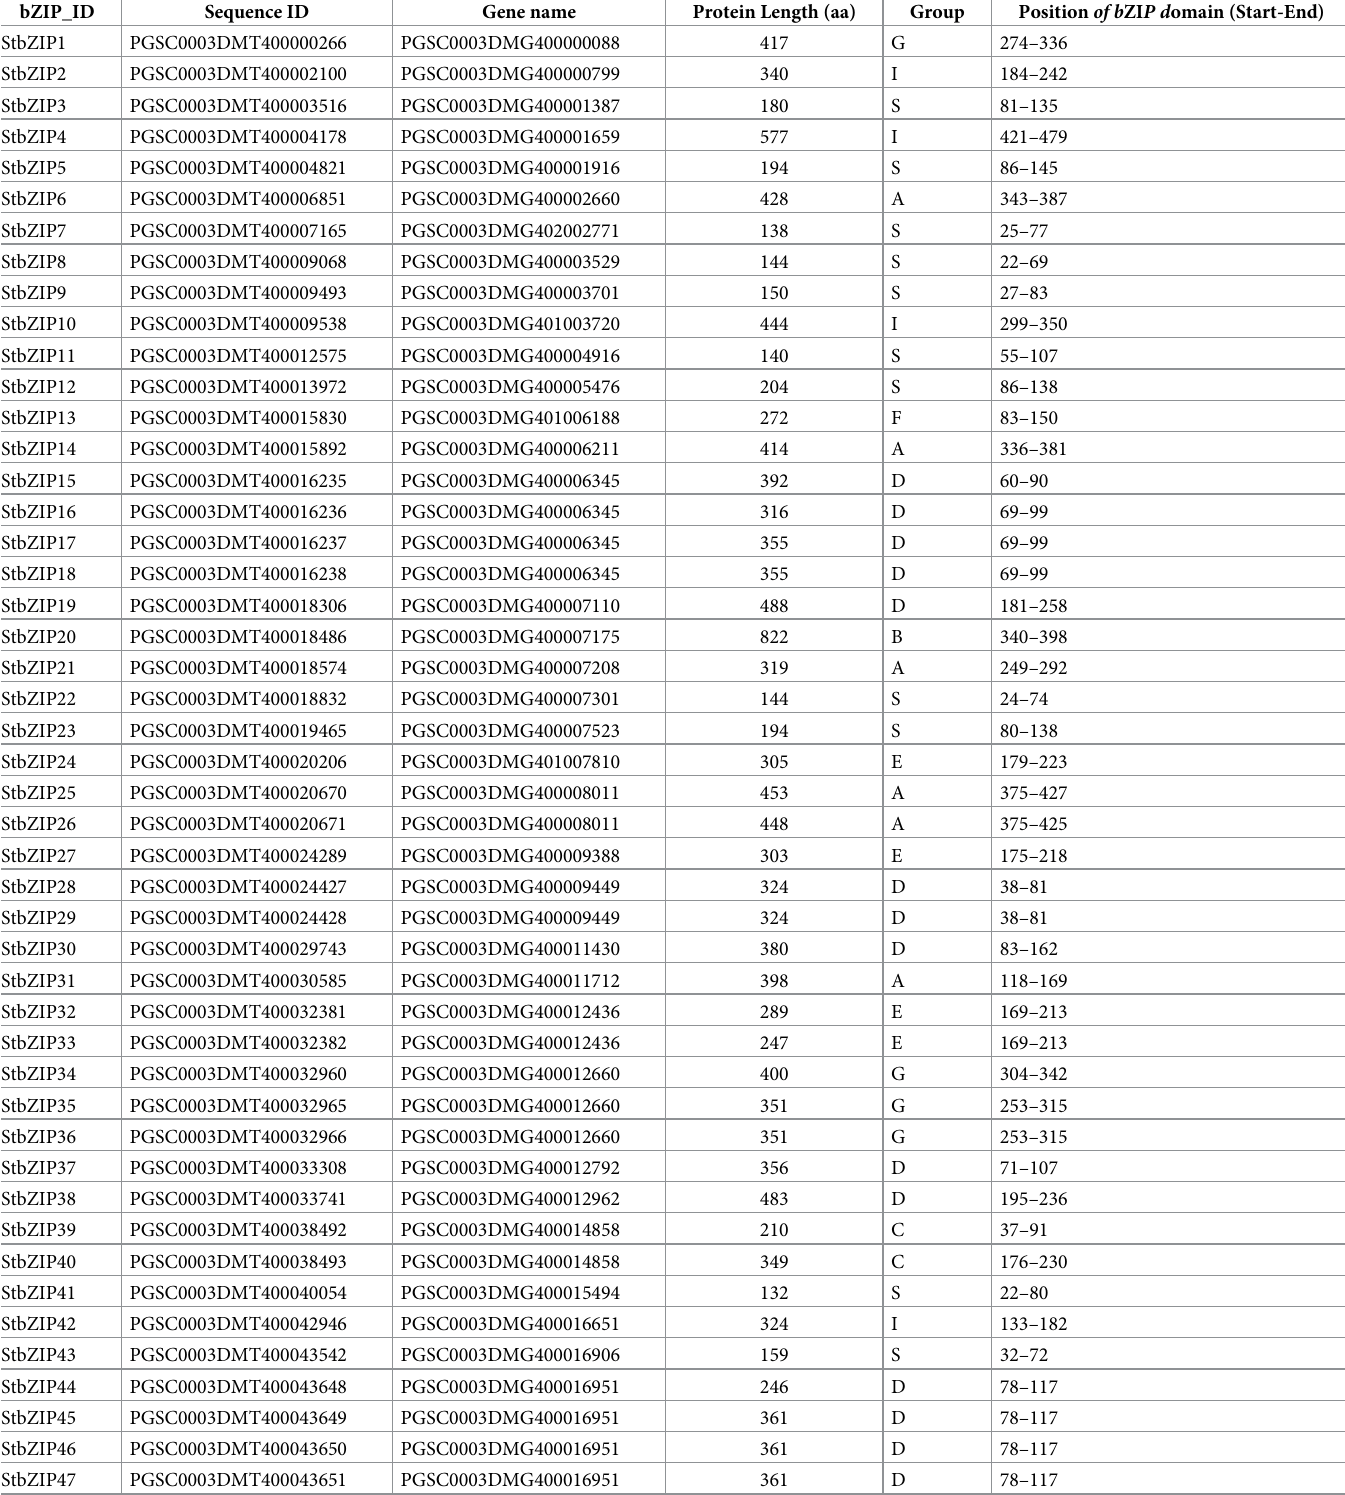
Table 1. List of ninety StbZIPs with sequence IDs, gene name, protein length, group, and domain position.